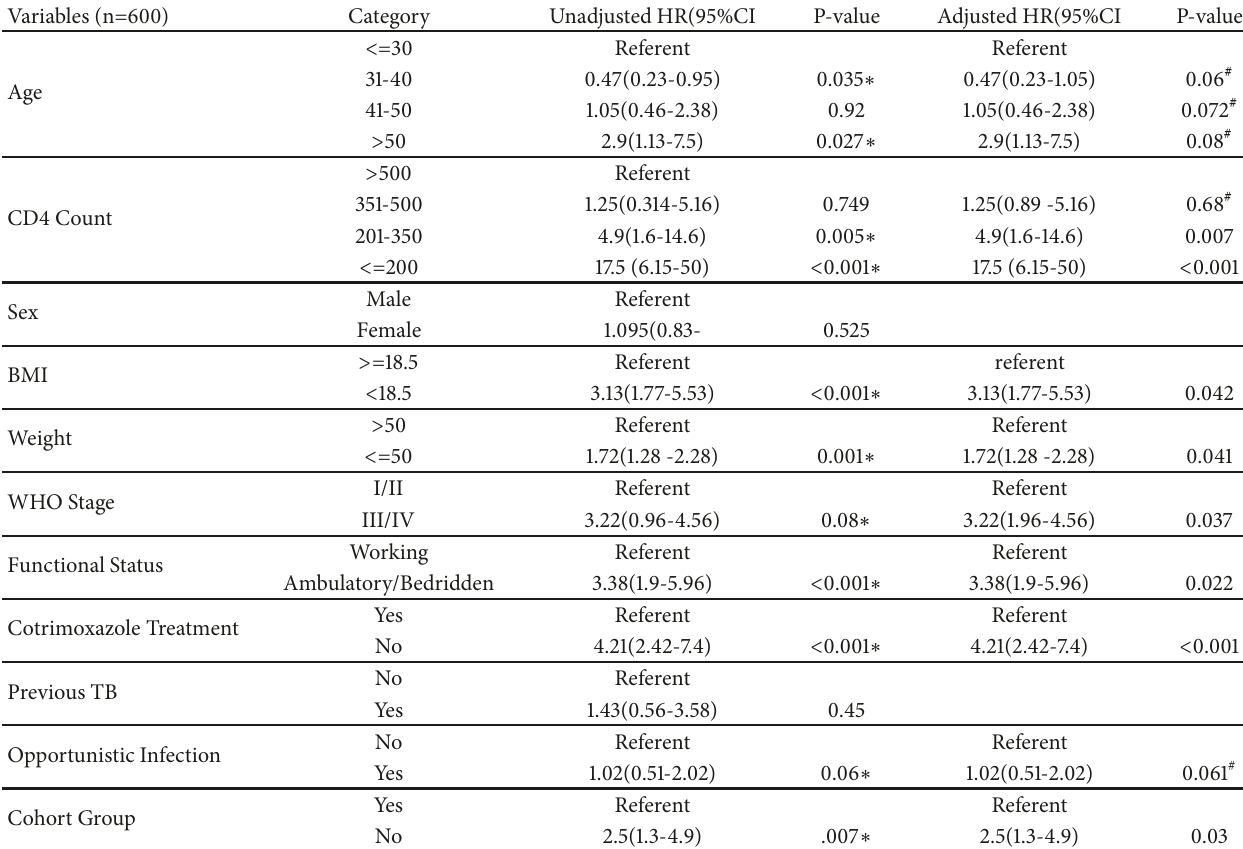
Table 4: Predictors of tuberculosis risk, multivariate analysis by Cox proportional hazard model of PLWHA at Nekemte referral hospital and Nekemte Health center followed from September 2009-September